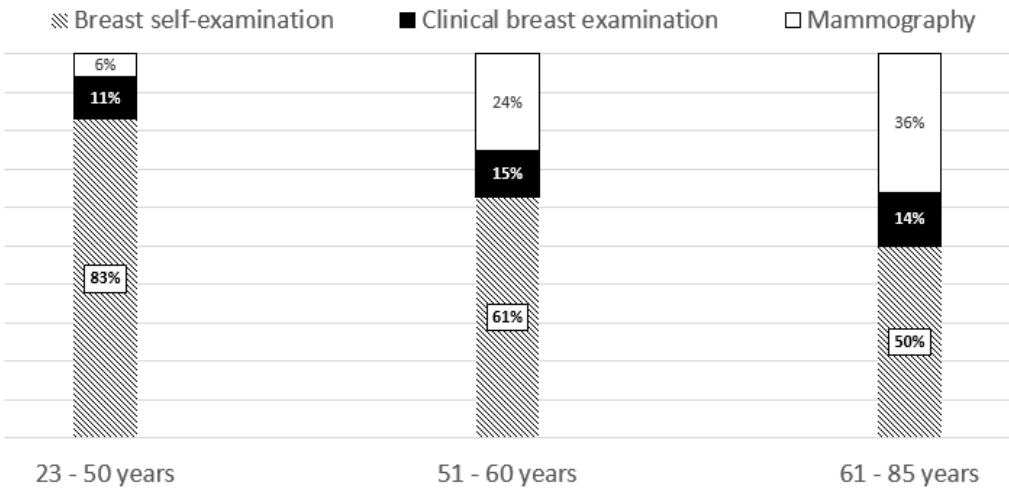
Figure 1. Modes of detection of breast cancer suspected changes according to age at diagnosis. Table 1. Modes of detection of breast cancer suspected changes according to the education level, employment and marital status, and family history of breast cancer, at the age of